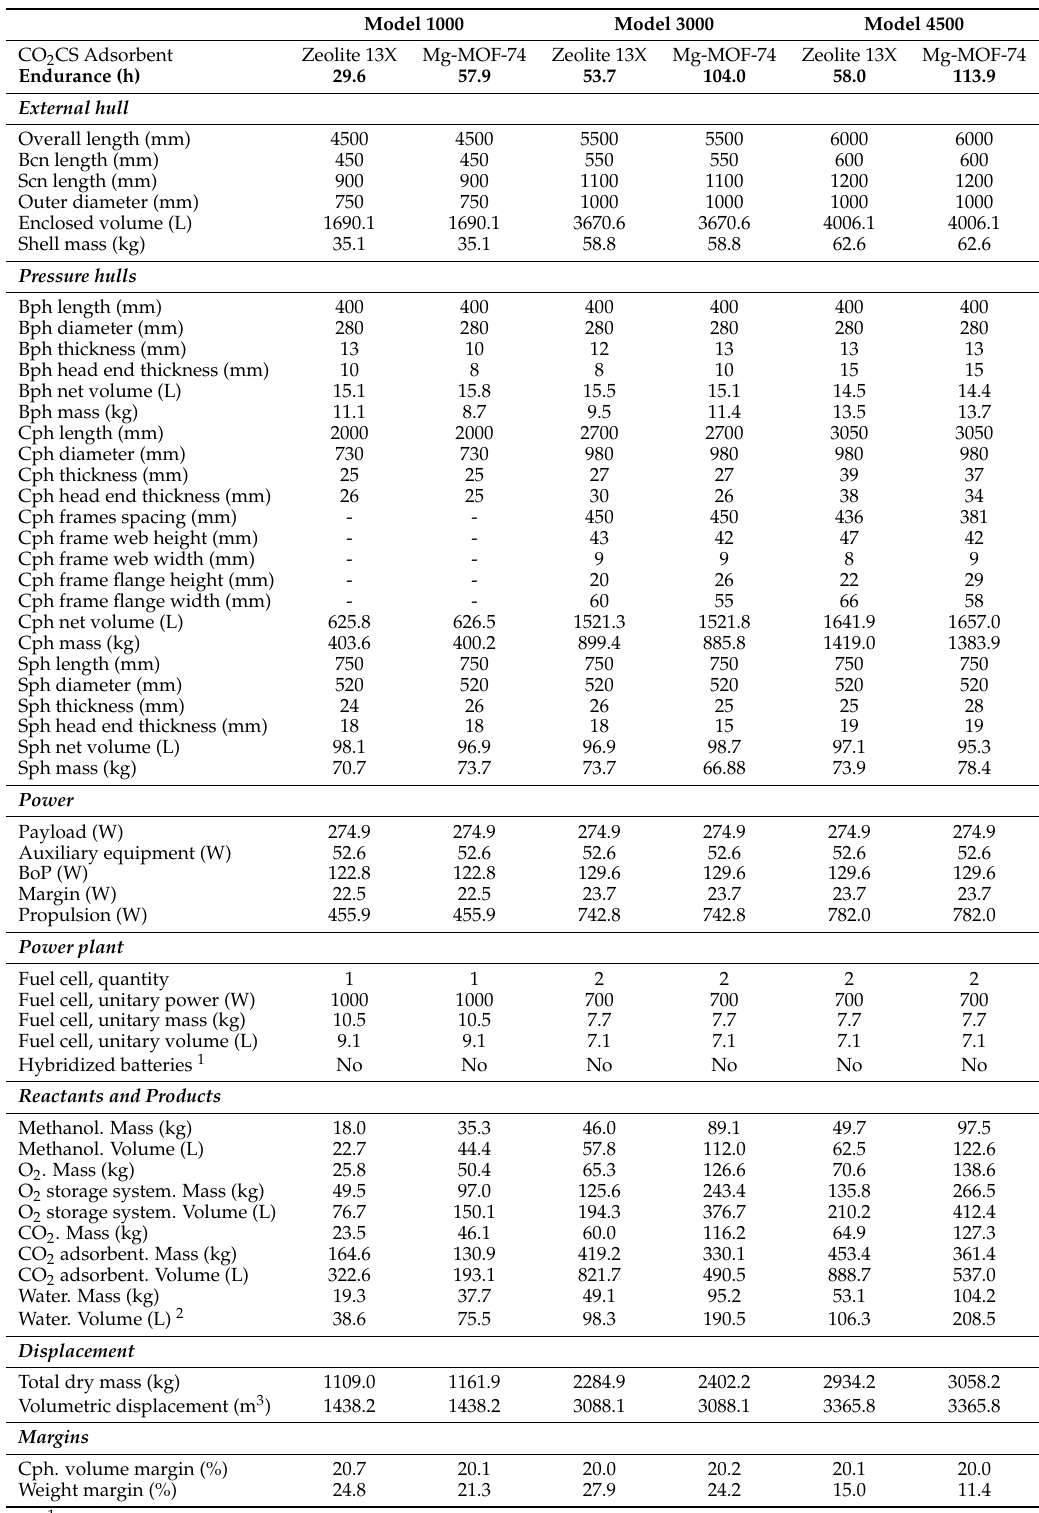
Table 5. Results obtained with DMFC-AUV\QpDM using the input parameter values listed in Table 4 and the operational profile showed in Table 3. Bcn, bow cone. Bph, bow pressure hull. Cph, central pressure hull. Sph, stern pressure hull. Scn, stern